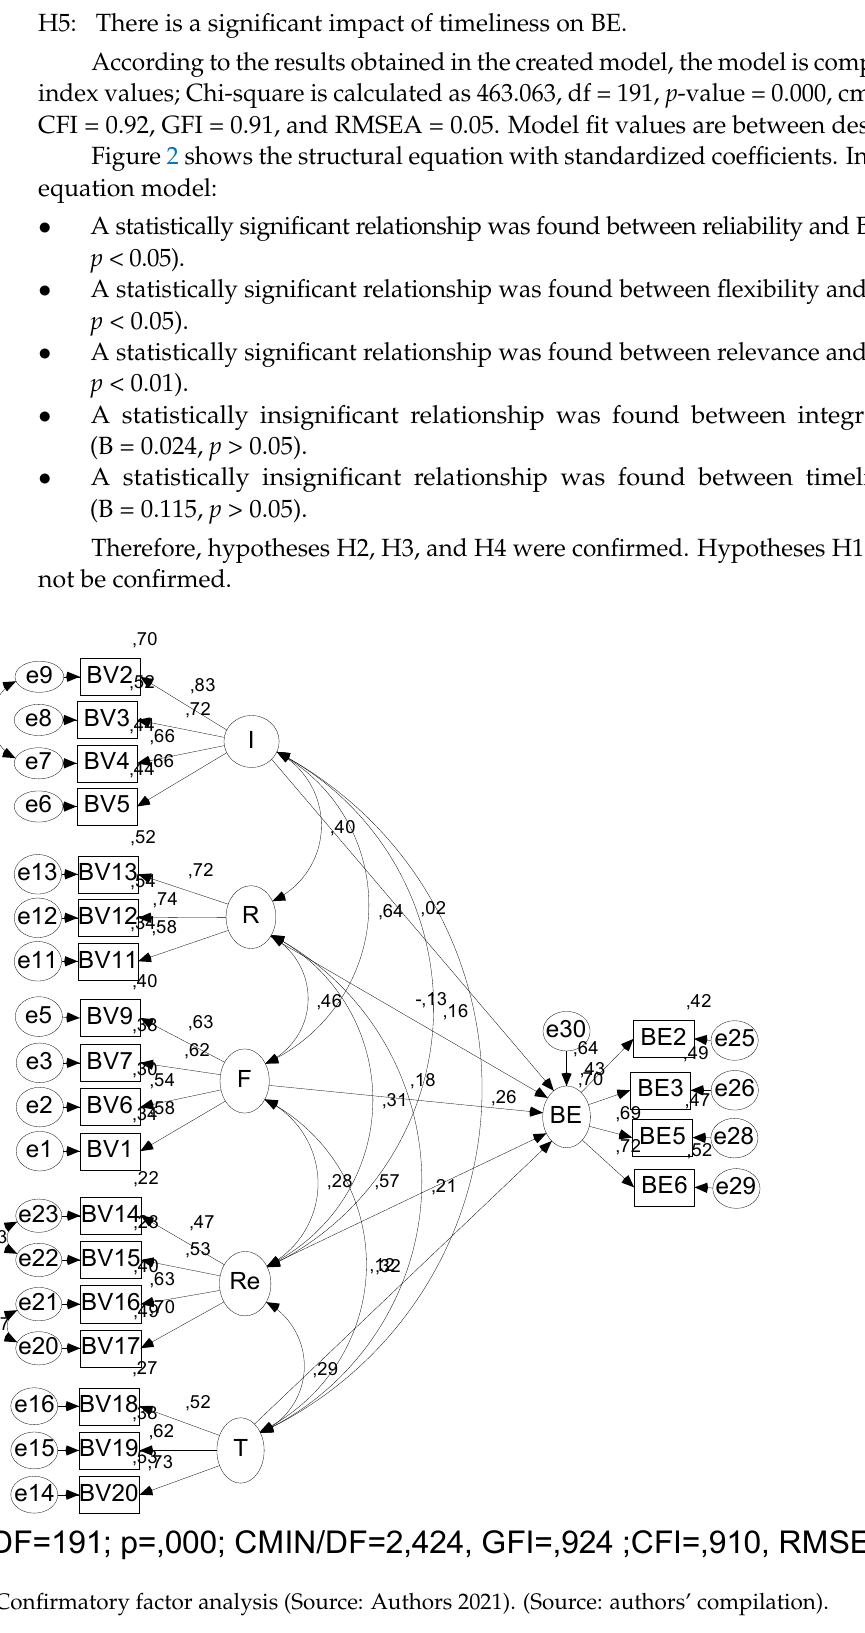
Figure 2. Confirmatory factor analysis (Source: Authors 2021). (Source: authors’ compilation).